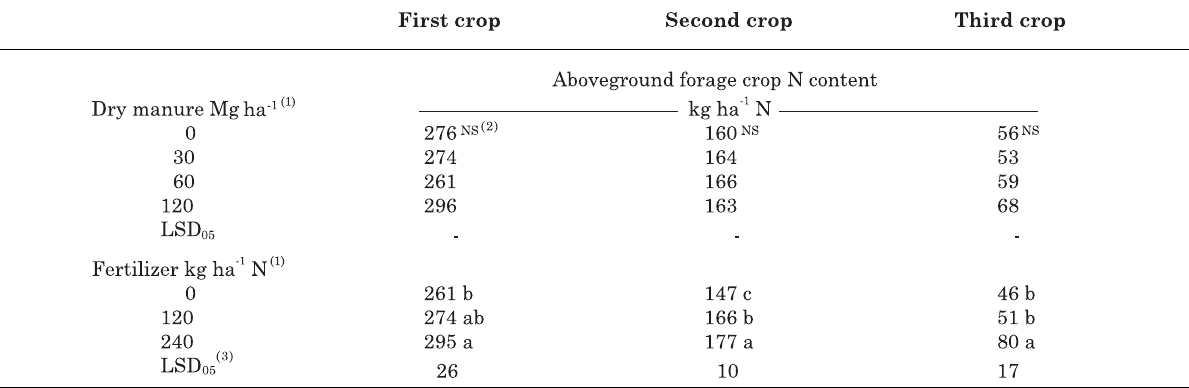
Table 3. Shoot N uptake by aboveground dry matter production by each forage crop, fertilized with four manure and three N fertilizer inputs. The first (annual ryegrass), second (sudangrass) and third (annual ryegrass) forage crops grown under four manure and three fertilizer rates, labeled with 15